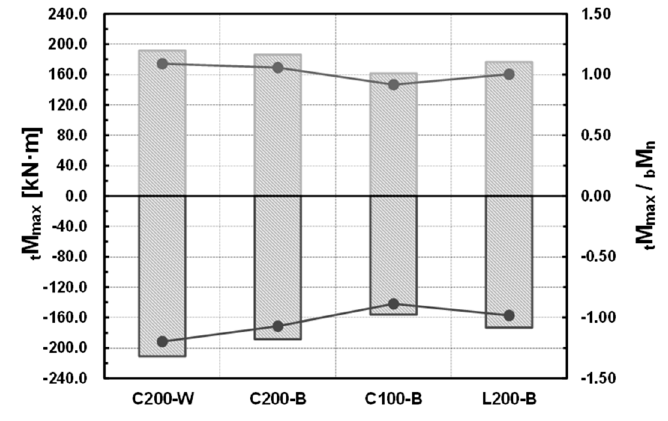
Figure 8. Maximum moment of the specimens (experimental results).